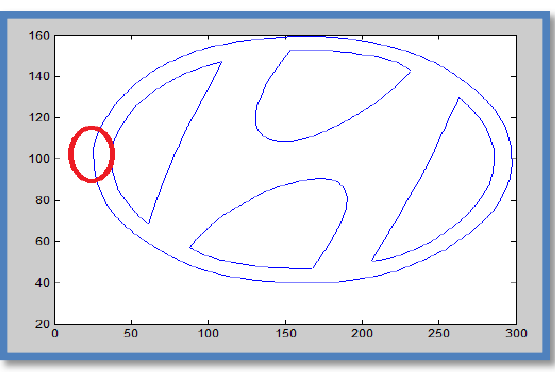
Fig. 4. Tool path using UG-NX program.